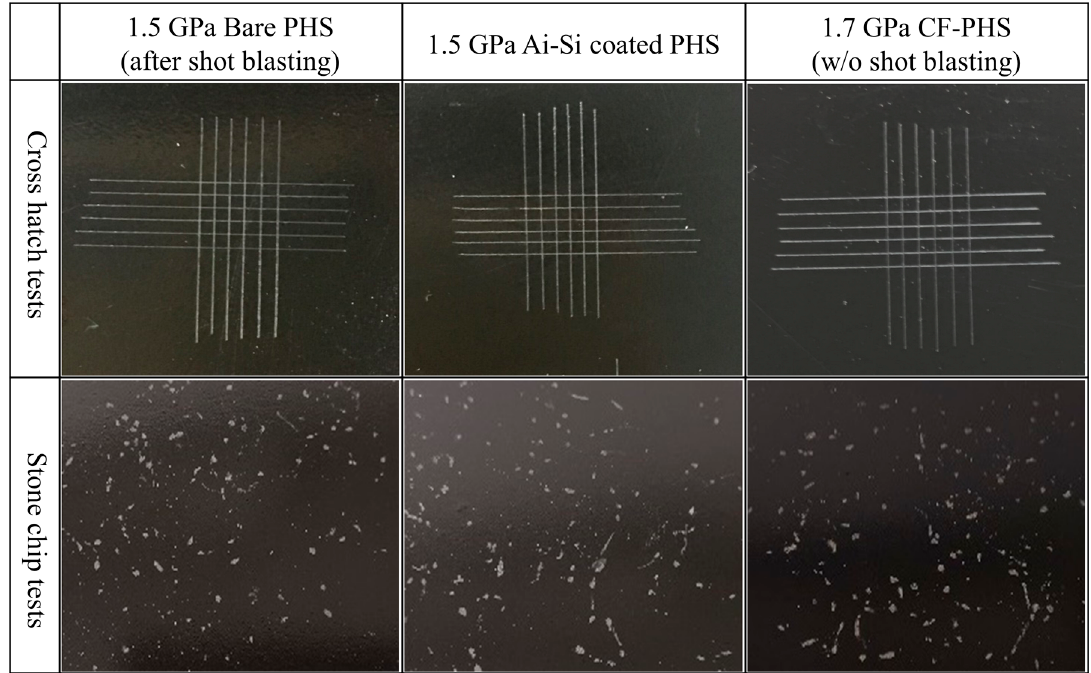
Figure 10. E-coat adhesion comparison of 1.5 GPa bare PHS, 1.5 GPa Al-Si coated PHS, and 1.7 GPa CF-PHS.